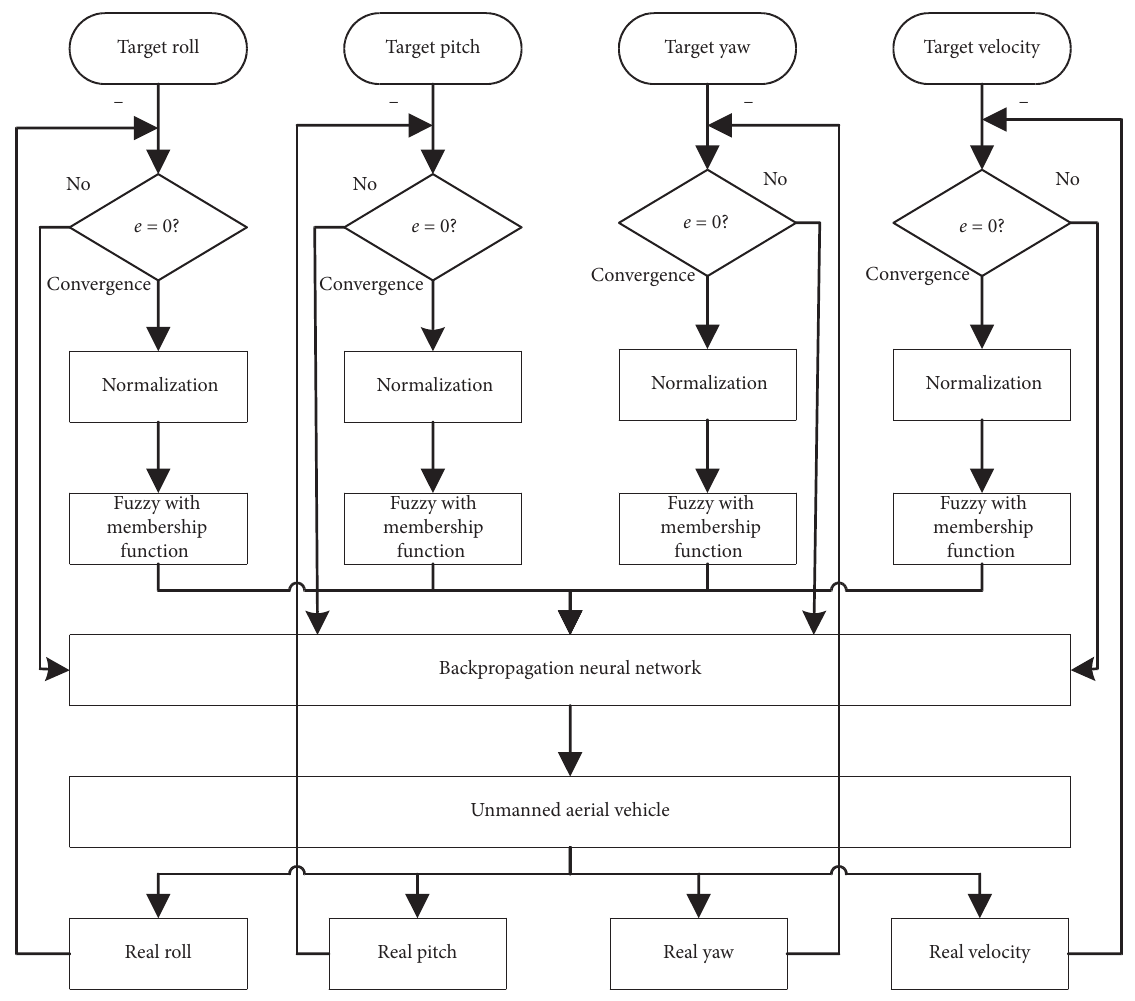
Figure 5: Fuzzy neural network learning